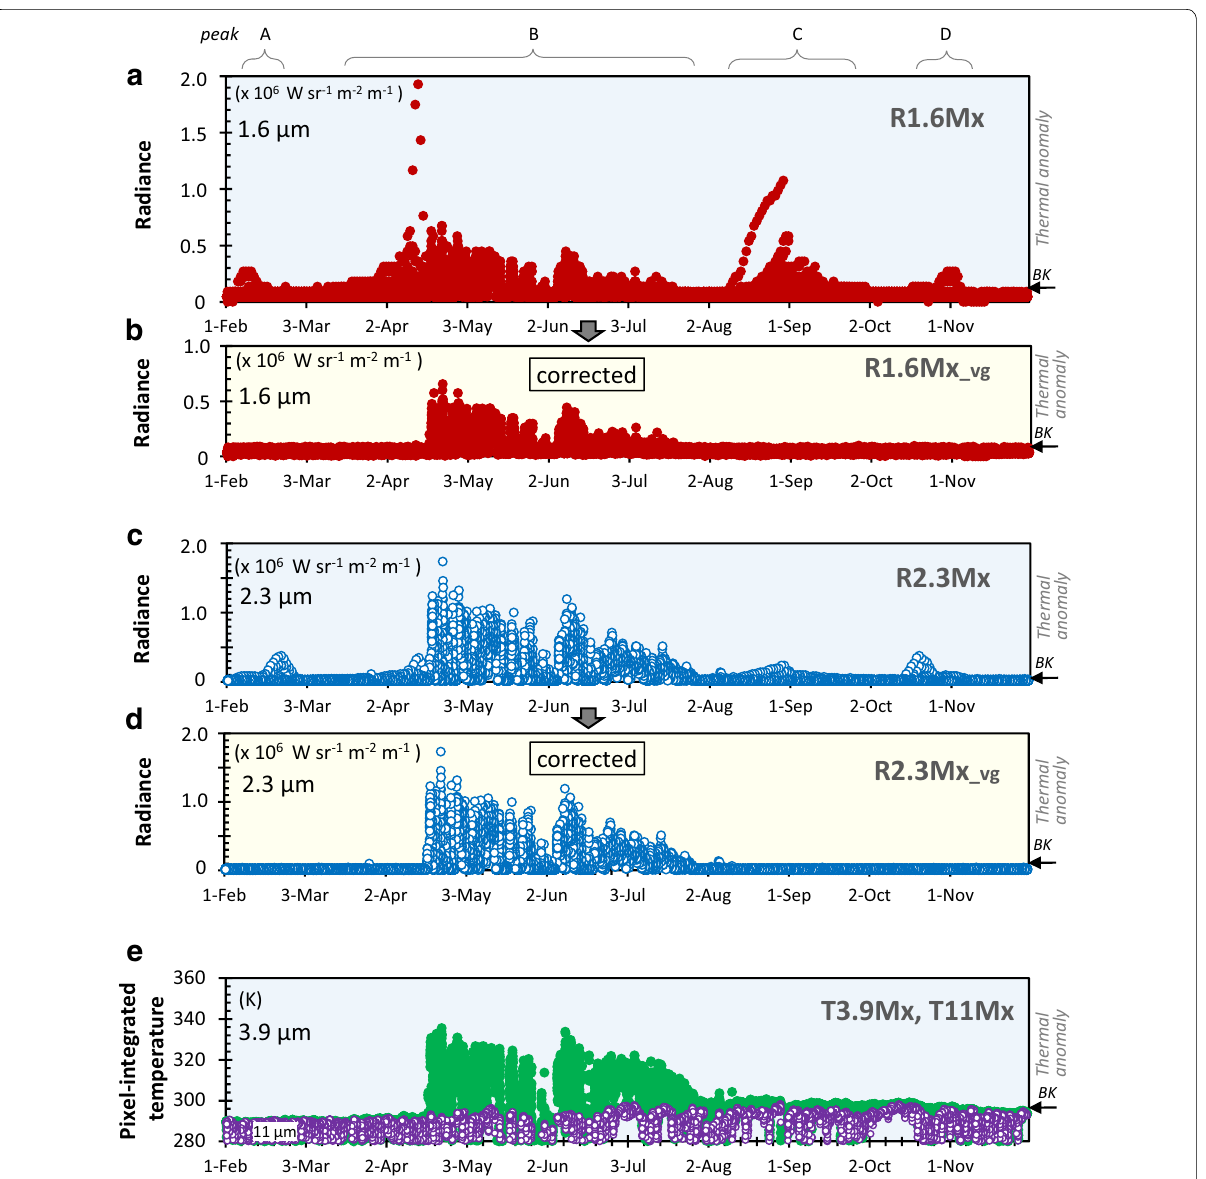
Fig. 5 Comparison between uncorrected and corrected data for stray light using the time-series variation of the nighttime thermal anomalies in the 1.6-µm and 2.3-µm images from February to November 2017 during the Nishinoshima eruption. a R1.6Mx (uncorrected), b R1.6Mx _vg (corrected), c R2.3Mx (uncorrected), d R2.3Mx _vg (corrected), and e T3.9Mx and